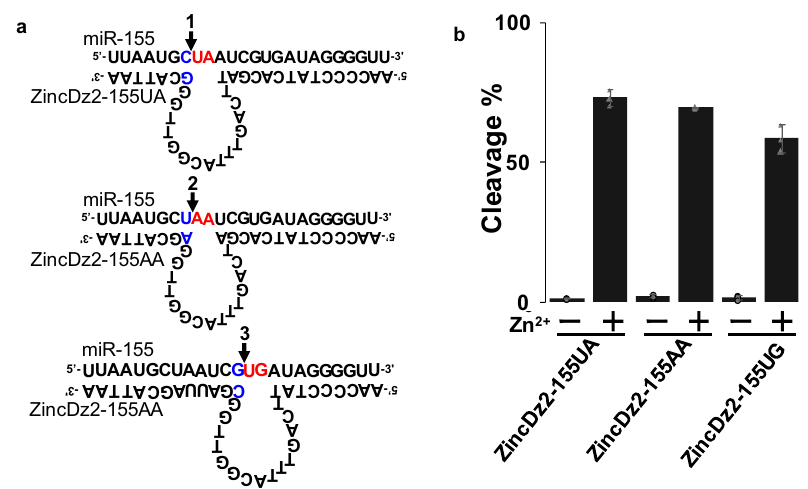
Fig. 5 Cleavage of miR-155 by designed ZincDz2. a Systematically designed DNAzymes targeting microRNA-155 (miR-155). The cleavage sites of ZincDz2-155UA, ZincDz2-155AA, and ZincDz2-155UG are indicated by arrows 1, 2, and 3, respectively. The core substrate regions are represented in red, and the optimized duplex bases in blue. b Cleavage activities of ZincDz2-155UA, ZincDz2-155AA, and ZIncDz2-155UG were measured under the single turnover condition, in the reaction buffer (50 mM HEPES, pH 7.5, 150 mM NaCl) in the presence of 1 mM Zn 2 + . The data shown are presented as means ± SD from three independent